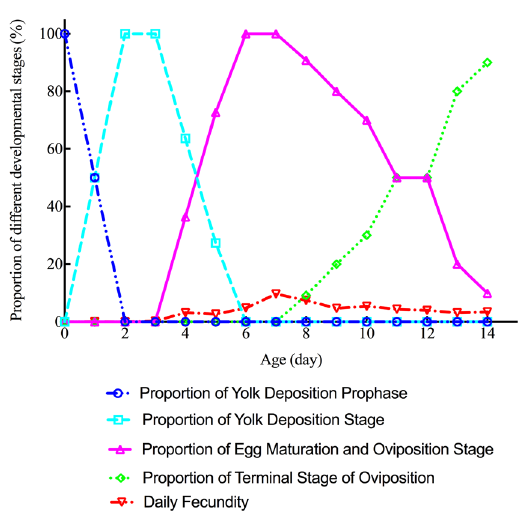
Figure 6. The relationship between daily fecundity and the proportion of OFM females in each ovarian developmental stage.